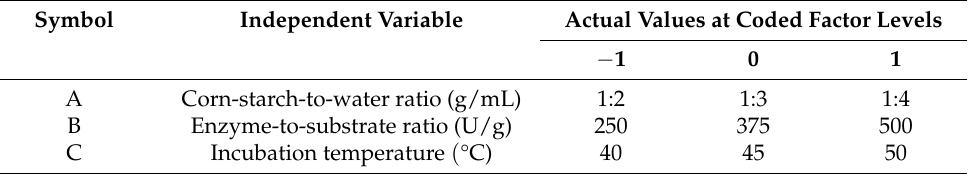
Table 1. Actual values at the coded factor levels of the independent variables used in the RSM method. Symbol Independent Variable Actual Values at Coded Factor Levels − 1 0 1 A Corn-starch-to-water ratio (g/mL) 1:2 1:3 1:4 B Enzyme-to-substrate ratio (U/g) 250 375 500 C Incubation temperature ( °C) 40 45